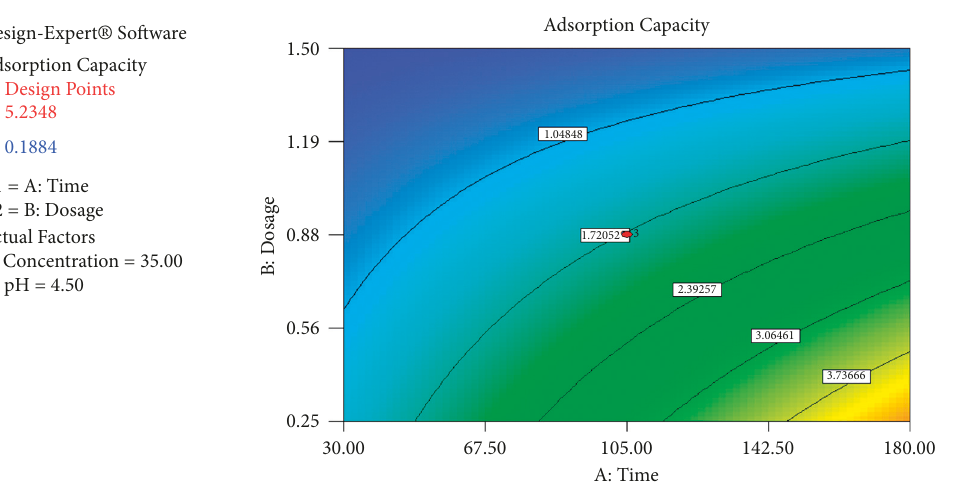
Figure 2: Contour plot for the interaction between time and dosage on adsorption capacity of BRR